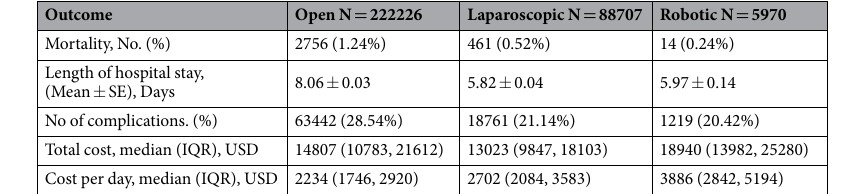
Table 3. Comparison of elective surgeries for localized pathology.